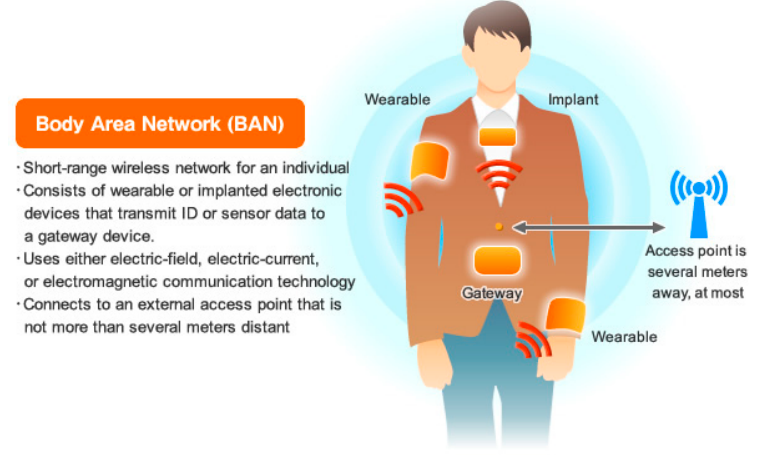
Figure 1. A body area network with sensors connects with the access point via a gateway [8,9].